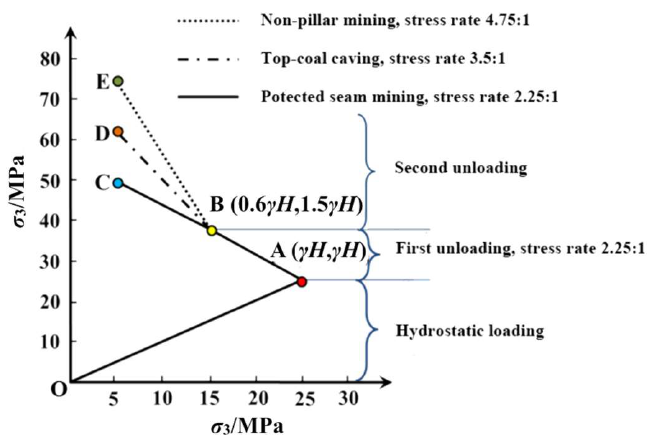
Figure 5. The loading (unloading) scheme under different mining layouts ( γH = 25 MPa).